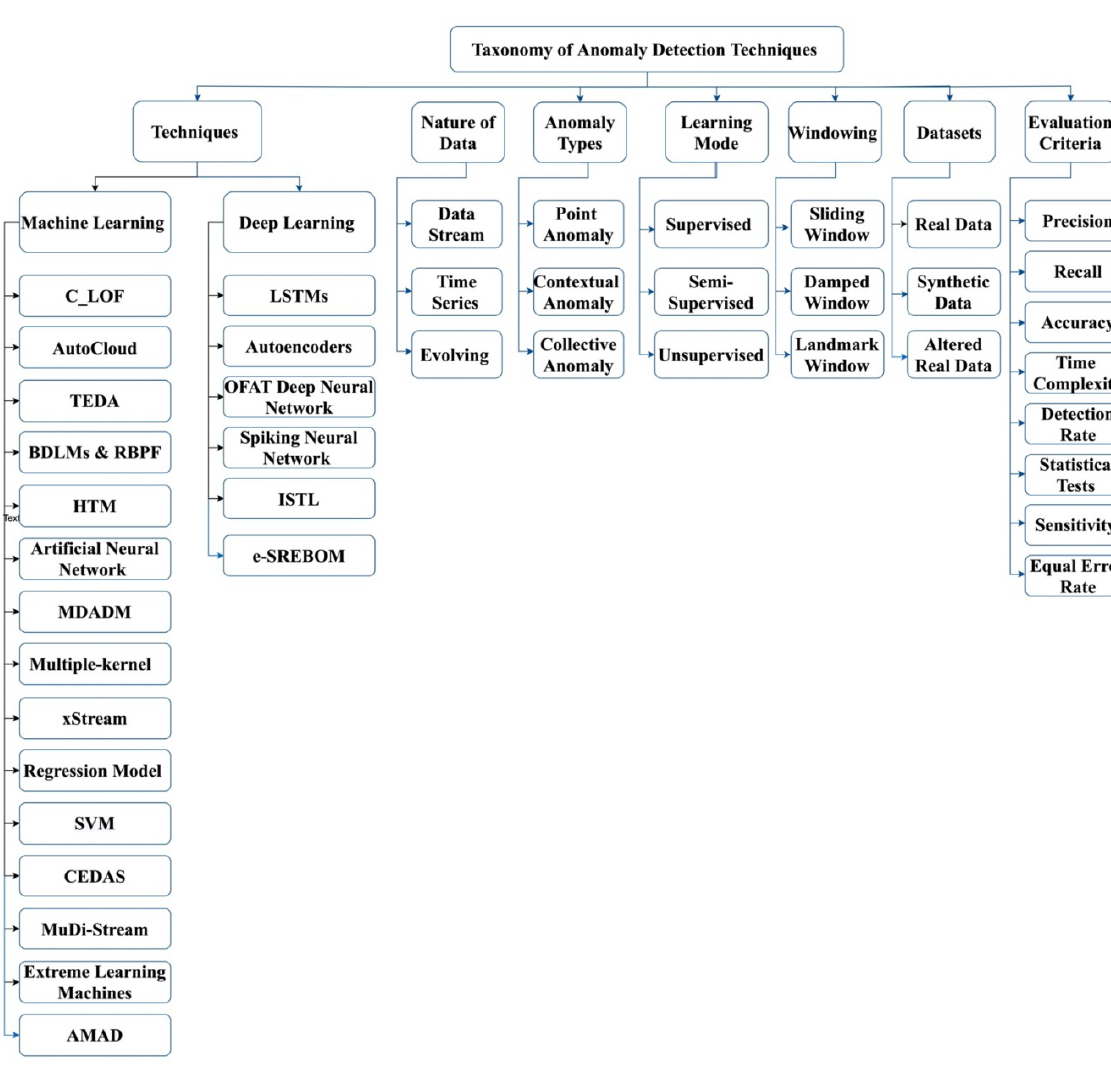
Figure 2. Taxonomy of anomaly detection techniques.